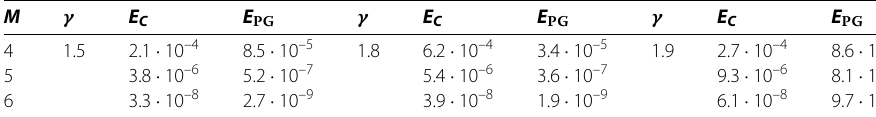
Table 1 Maximum pointwise error of Example 1